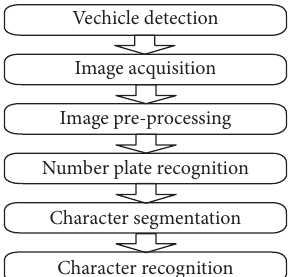
Figure 1: Proposed design process flow.